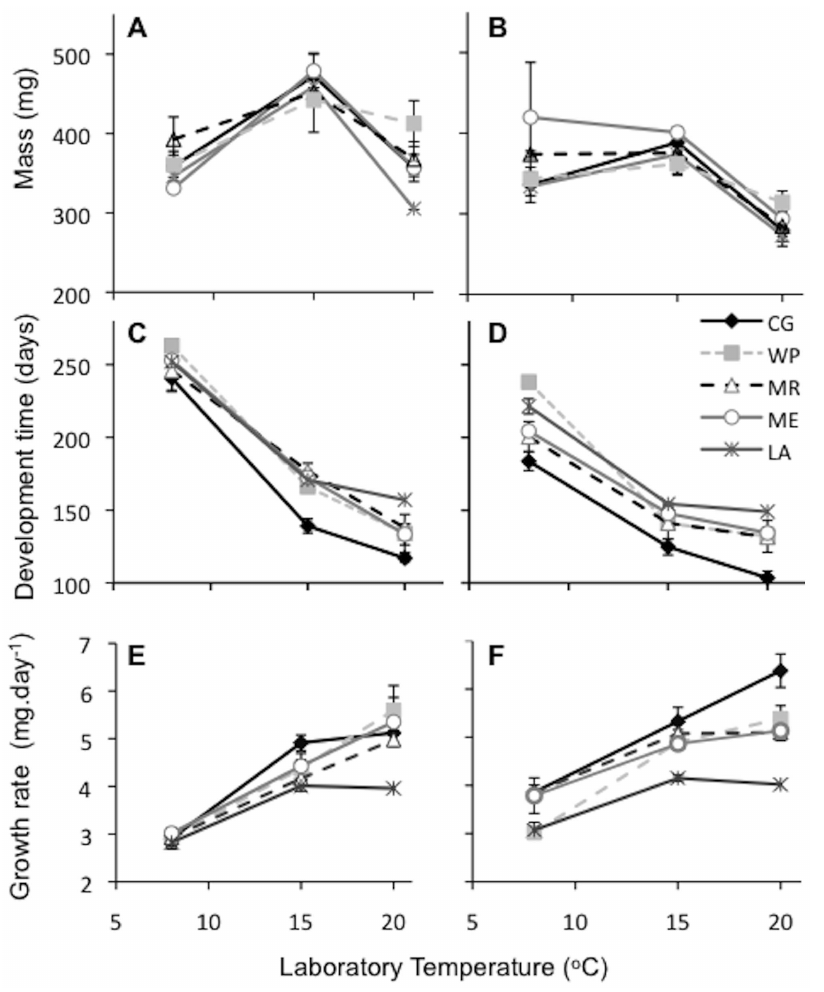
Figure 3. Geographic patterns in growth, development, but not size. No geographic variation in pupal mass (a,b) was detected, despite a significant population effect on (c,d) larval development and (e,f) growth rate of H. merope larvae reared in the laboratory. Data are sorted by sex, and populations are listed in order of decreasing latitude (north to south in the Southern hemisphere). Error bars denote SEM. doi:10.1371/journal.pone.0095258.g003 PLOS ONE |